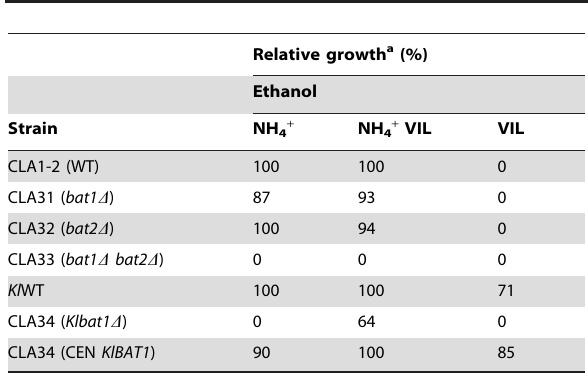
Table 3. Growth phenotypes of single and double bat1 D and bat2 D mutants.